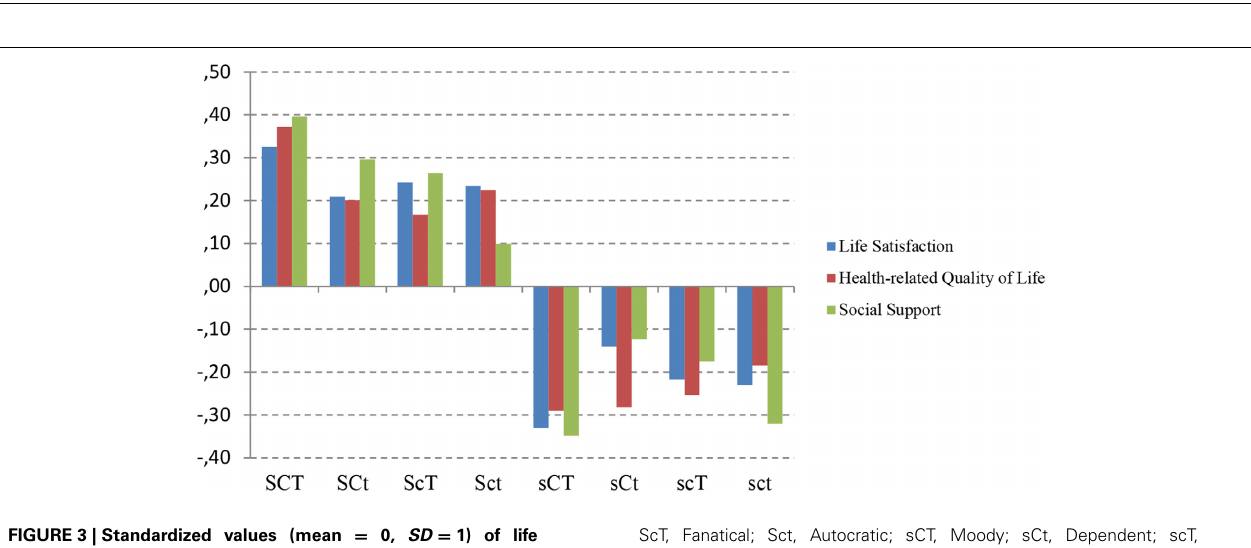
ScT, Fanatical; Sct, Autocratic; sCT, Moody; sCt, Dependent; scT, Disorganized; sct, Depressive; All three individual ANOVAs are significant at p < 0 . 05.